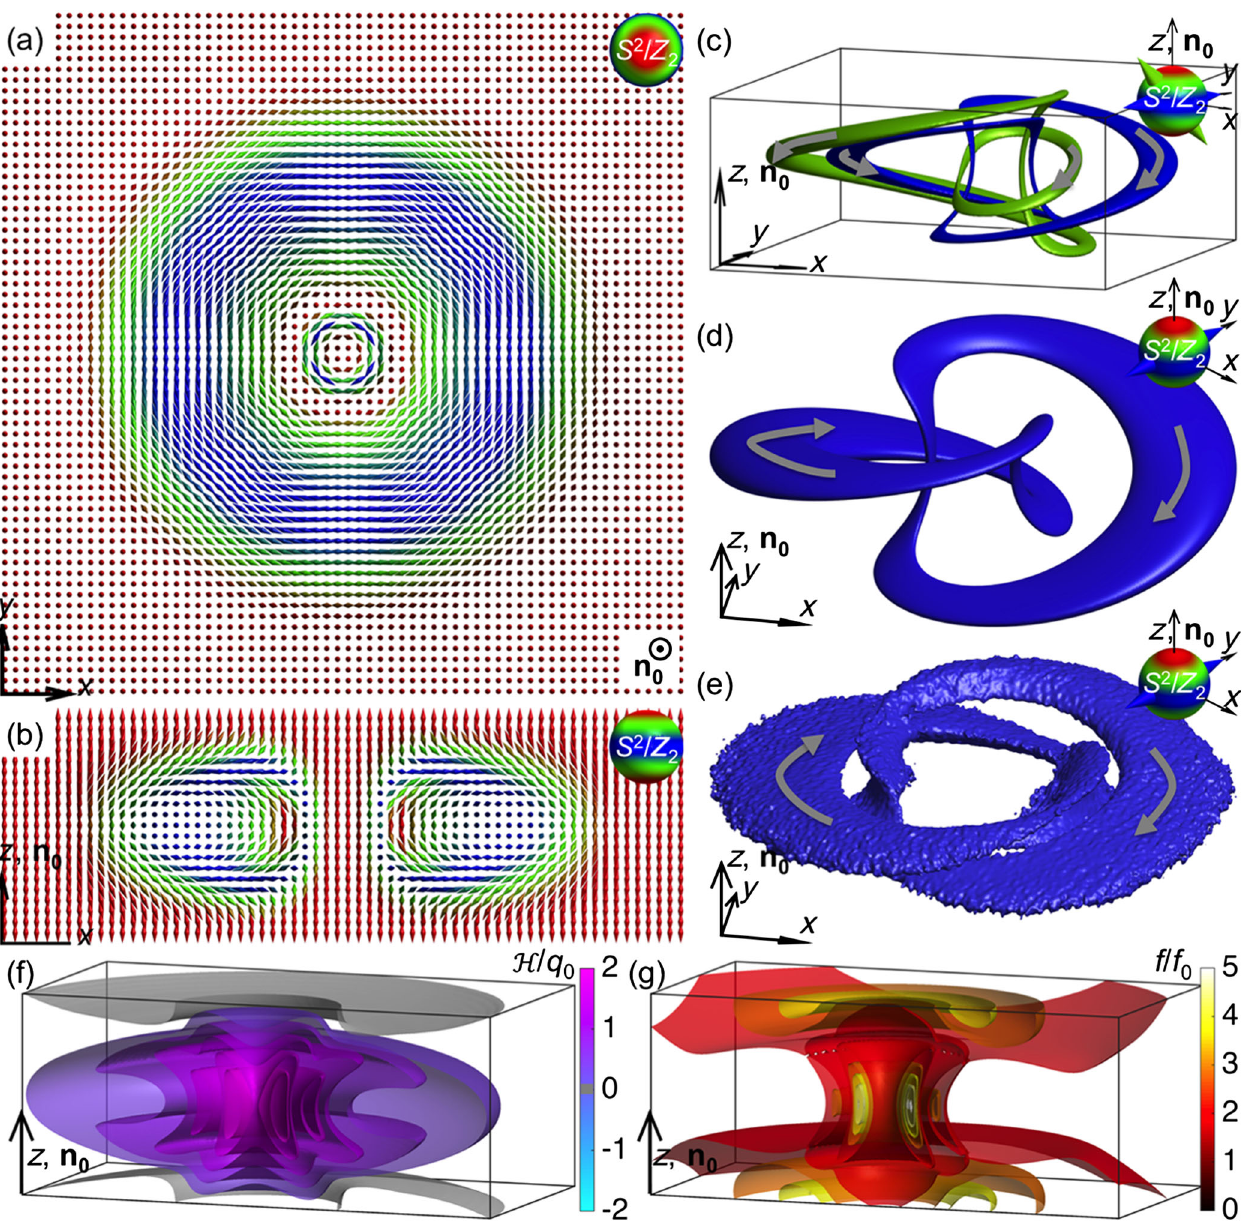
FIG. 5. 3D topological soliton with Q ¼ − 1 . (a), (b) Computer-simulated (a) in-plane and (b) vertical cross sections of the axially symmetric n ð r Þ structure of the Q ¼ − 1 hopfion depicted using double cones and the color scheme that establishes correspondence between director orientations and the points on S 2 =Z 2 (top right insets). (c) Computer-simulated preimages of the hopfion for two sets of the diametrically opposite points on S 2 =Z 2 marked by double cones in the top right inset. (d), (e) Comparison of representative (d) computer-simulated and (e) experimental preimages of the hopfion for two diametrically opposite points on the “ equator ” of S 2 =Z 2 (top right insets). Linking of the two closed loops establishes the Hopf index Q ¼ − 1 , as discussed in the text. Computer simulations are performed for elastic constants of 5CB while also assuming K 24 ¼ 0 . The preimages are reconstructed based on 3PEF-PM images of structures in a 5CB-based partially polymerizable nematic LC mixture with a chiral additive CB-15, in a cell with d ¼ 10 μ m and d=p ∼ 1 ; before imaging, the unpolymerized 5CB is replaced by immersion oil. Gray arrows in (c) – (e) indicate the consistently determined circulations of the preimages. (f),(g) Perspective views of the 3D computer-simulated isosurfaces of normalized (f) handedness and (g) free-energy density for this axially symmetric hopfion, with the corresponding color schemes shown in the right-hand side